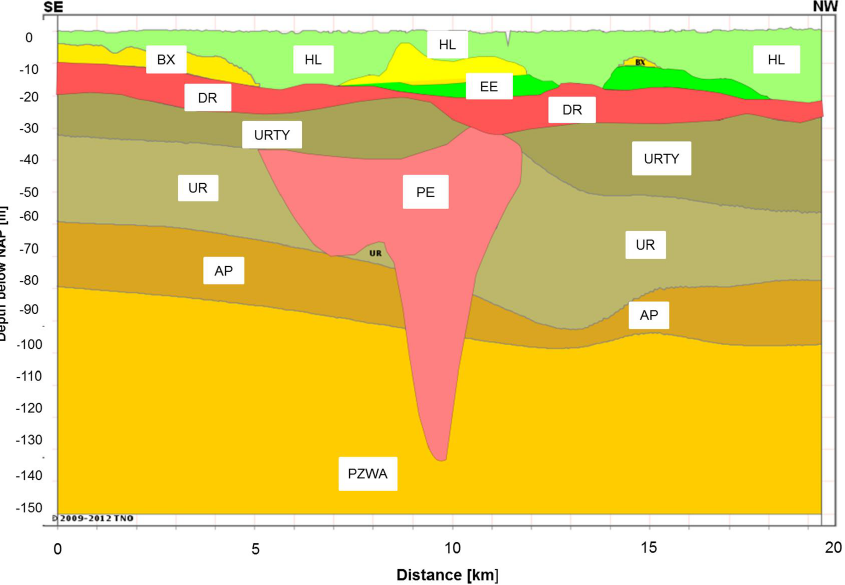
Fig. 2. Geological cross-profile showing the main geological units. For explanation of the abbreviation of the geological units, see the main text. For the location of the profile, see Fig. 3.